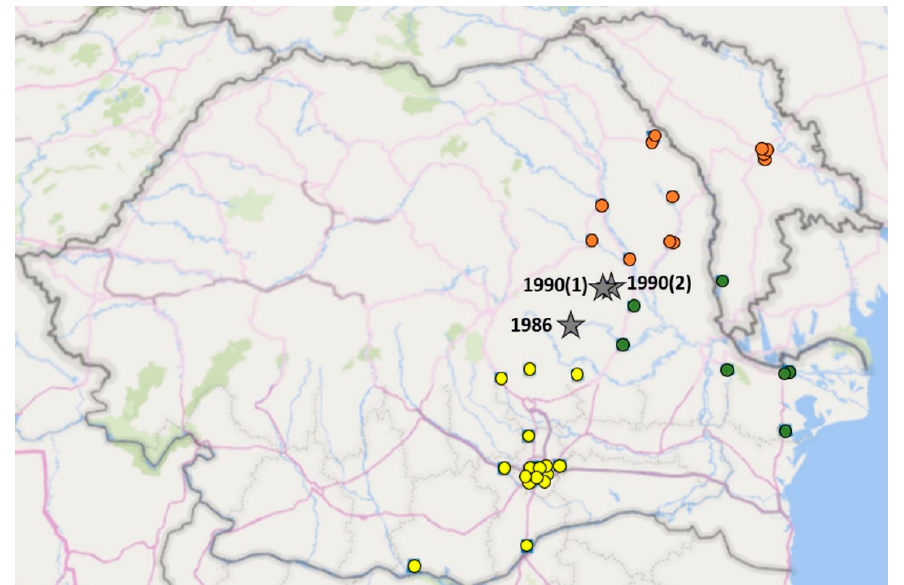
Figure 5. Positions of the recording seismic stations and epicenters of the Vrancea intermediate ‐ depth earthquakes of August 1986 and May 1990. The color code is as follows: orange—zone 1 seismic stations, green—zone 2 seismic stations and yellow—zone 4 seismic stations.